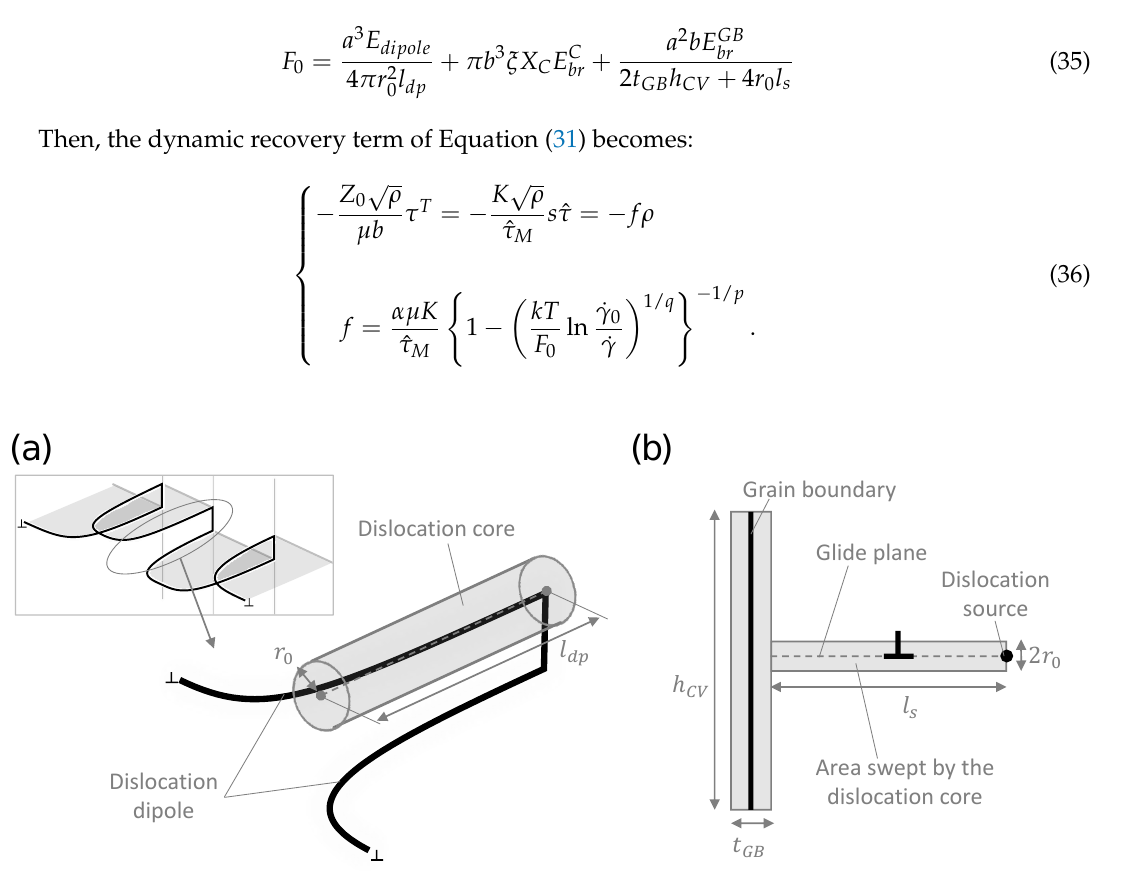
Figure 5. Schematic illustration of the volume and the area of atoms involved in an interaction with: ( a ) dislocation; and ( b ) grain